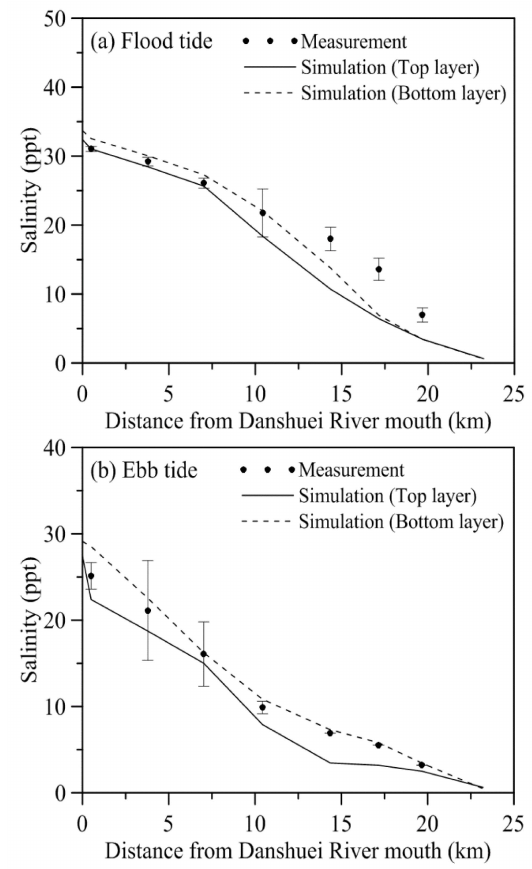
Figure 4. The comparison between the measured and simulated salinities along the Danshuei River–Tahan Stream on 26 November 2010 during ( a ) flood tide and ( b ) ebb